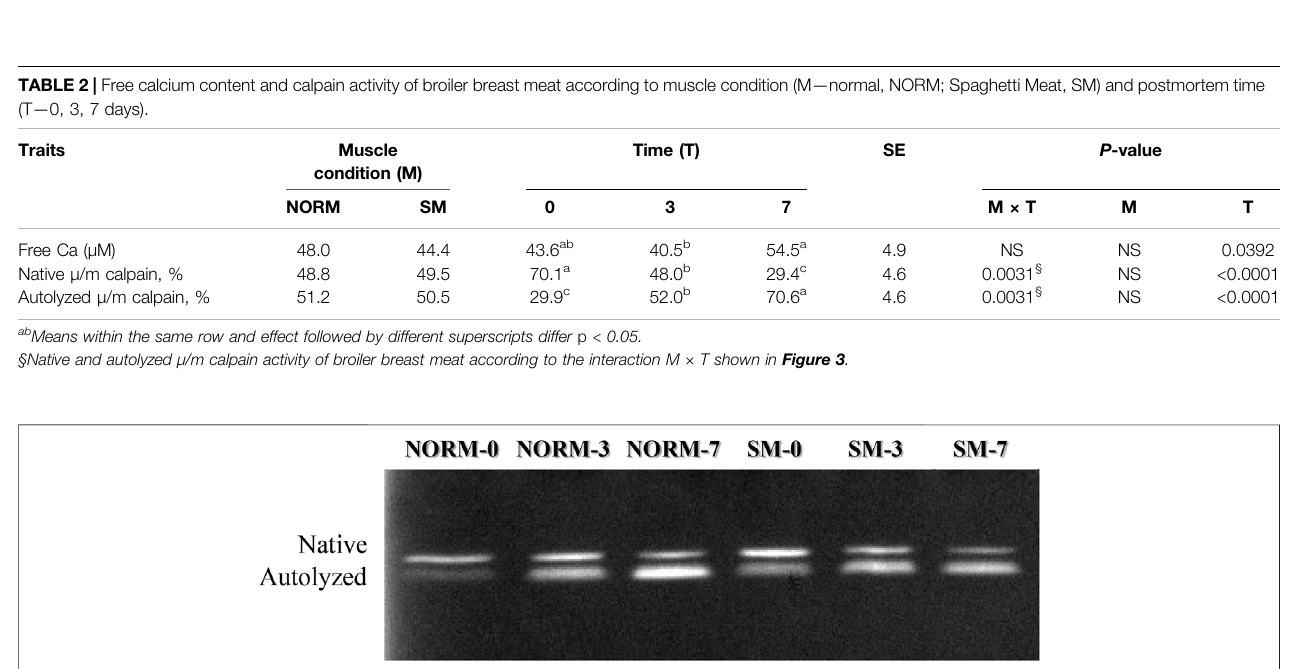
Frontiers in Physiology |